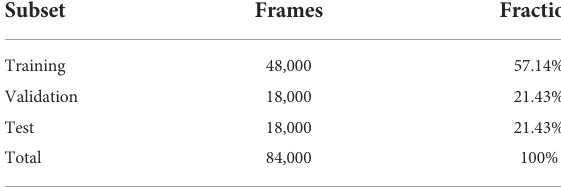
TABLE 2 The distribution of the